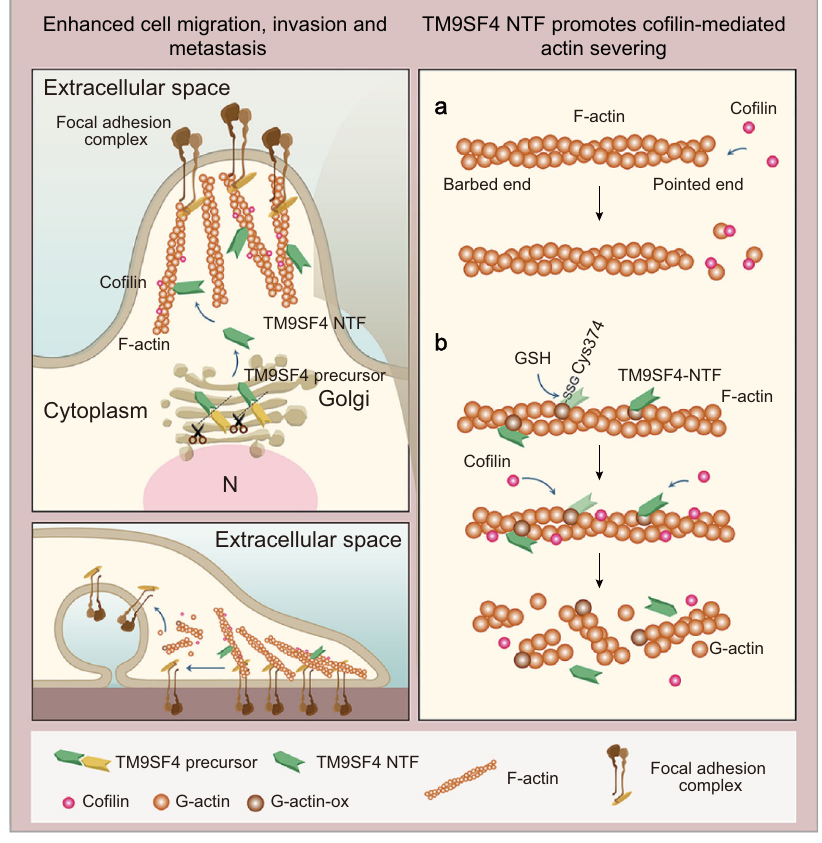
Fig.7|AschematicmodelforactindisassemblyviaTM9SF4. Aschematicmodel is proposed based on the present fi ndings. Upper left, top view; lower left, side view;right,schematics. a typically,co fi lincanbindtoF-actinatthepointedendand sever actin/ADP monomers from the end. This process is relatively slow and low- ef fi cient. b TM9SF4iscleavedtoreleaseitsN-terminalfragment(NTF)intocytosol.